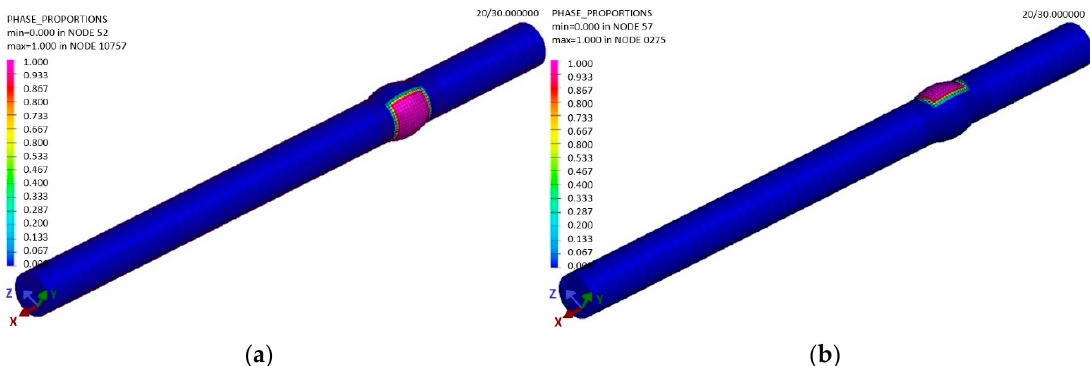
Figure 18. The distribution of ( a ) the welding metal of the first weld bead (Phase 2) at the end of the sample welding in the period t = 30 s and ( b ) the welding metal of the second bead (Phase 3), according to the simulation designed in the software SysWeld.